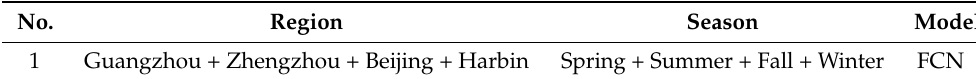
Table 5. Experimental setup for E3.